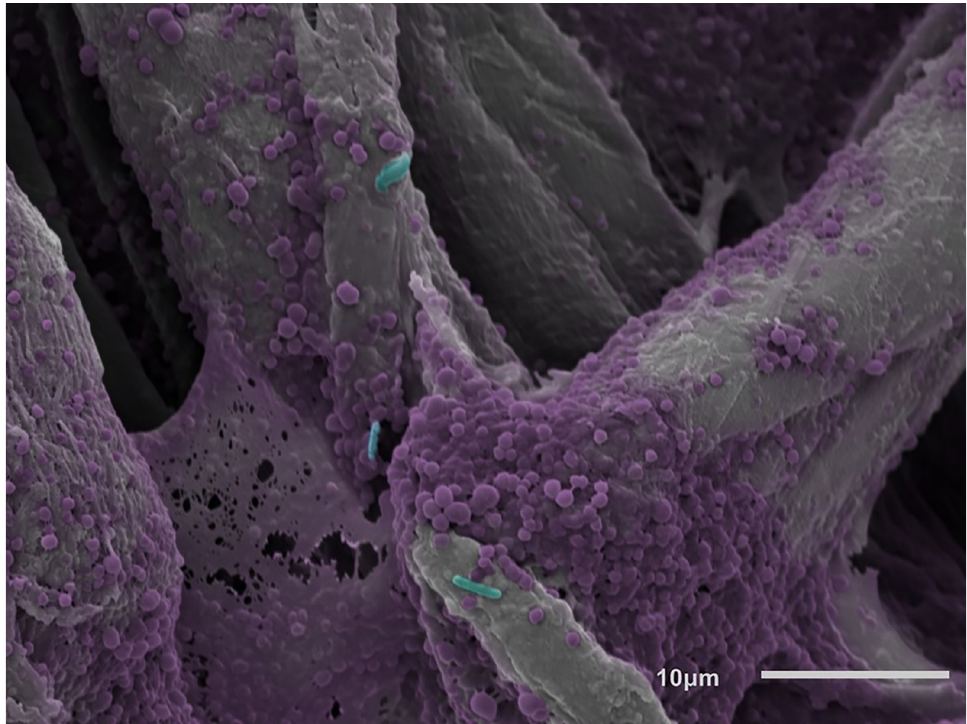
Fig 4. Polymicrobial biofilm on the non-treated side of a cellulose disc. Biofilm growth can be seen within chasms and voids between cellulose fibers.